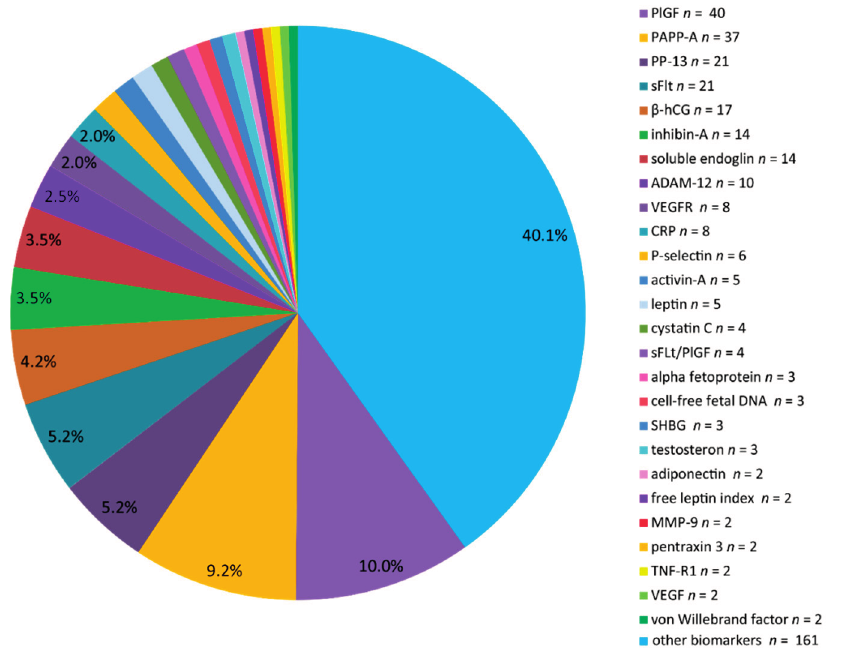
Figure 3. Distribution of studied laboratory biomarkers ( n = 401) in included articles ( n = 147). PlGF: Placental growth factor; PAPP-A: Pregnancy associated plasma protein A; PP-13: Placental protein 13; ADAM-12: a disintegrin and metalloprotease 12; CRP: C-reactive protein; sFlt: Soluble fms-like tyrosine kinase-1; MMP-9: Matrix metallopeptidase 9; TNF-R1: Tumour-necrosis factor receptor-1; VEGF: Vascular endothelial growth factor; VEGFR: Vascular endothelial growth factor receptor; SHBG: Sex hormone-binding